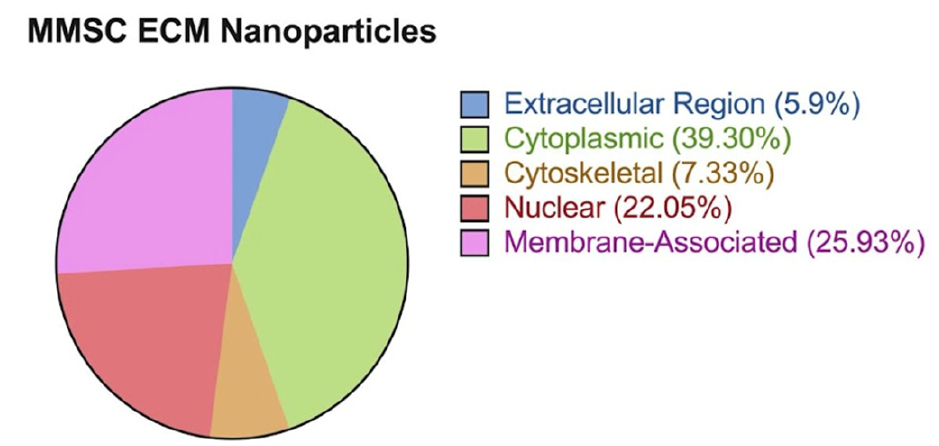
Figure 2. Comparison of the location of ECM proteins from the MMSC ECM nanoparticles.